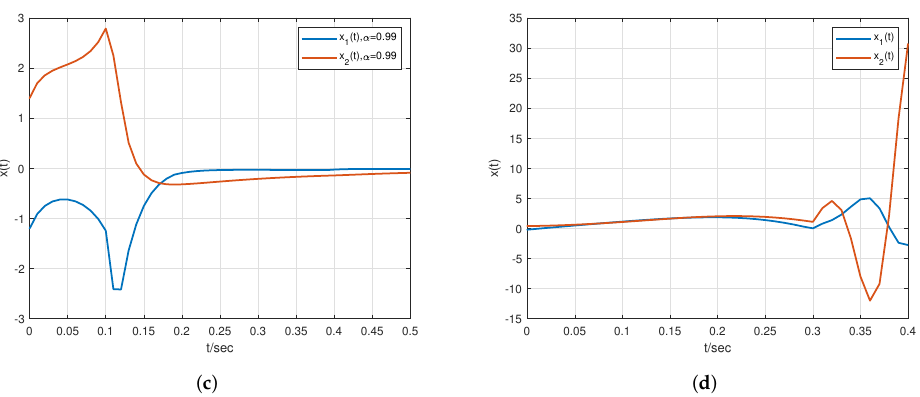
Figure 3. The panels ( a – c ) contain the curves of the state variable x 1 ( t ) and x 2 ( t ) for H ∞ performance with distinct FO circumstances α = 0.85,0.9,0.99. Moreover, the panel ( d ) is the trajectories of the open loop system in Example 1.